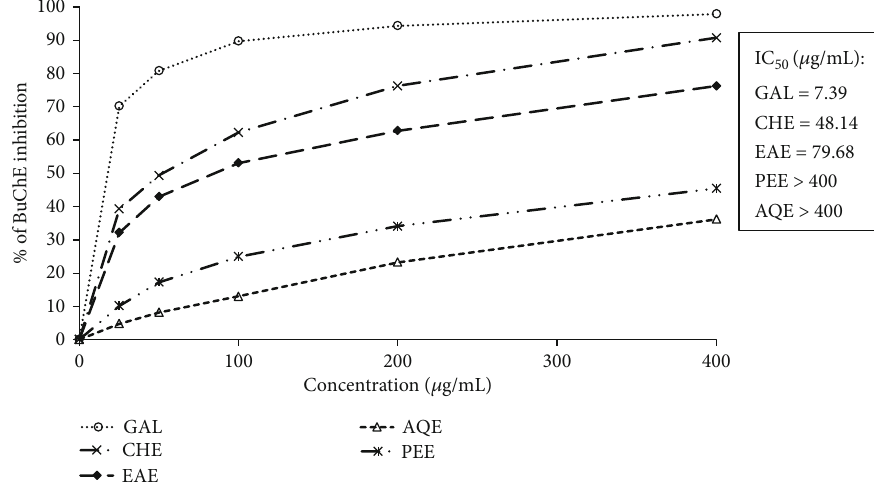
Figure 2: Inhibition of butyrylcholinesterase by di ff erent extracts of E . fl uctuans . Results represent mean ± SD ( n = 3 ). Galantamine (GAL) was used as a reference compound. CHE: chloroform extract; EAE: ethyl acetate extract; AQE: aqueous extract; PEE: petroleum ether extract; BuChE: